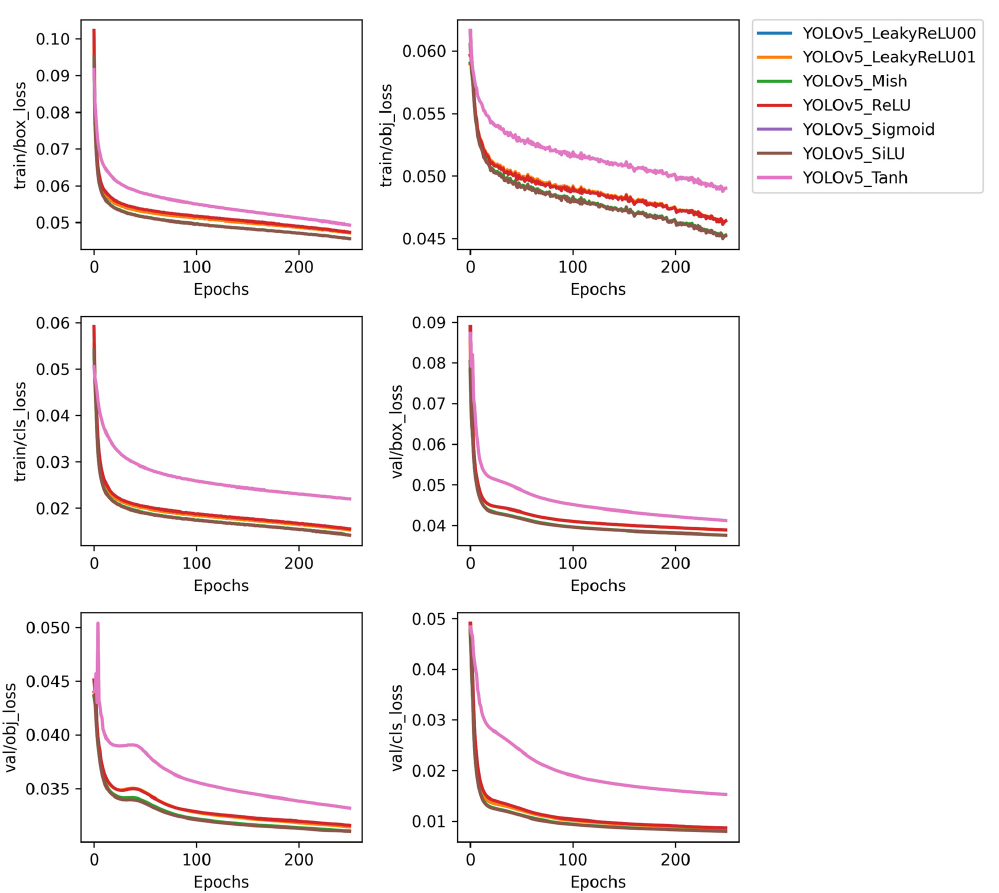
Figure 11. Training and validation loss functions of the proposed VPP framework based on the best candidate of the selected YOLOv5x over 250 epochs. The deep learning YOLOv5x is separately trained using six different activation functions: LeakyReLU, ReLU, Sigmoid, Mish, SiLU, and Tanh.